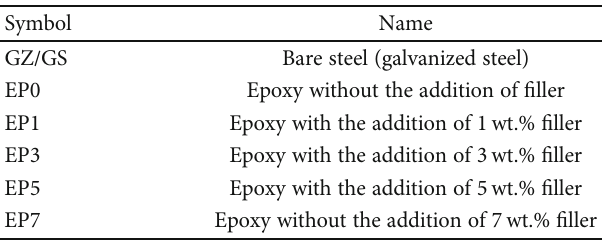
Table 1: Epoxy samples speci fi